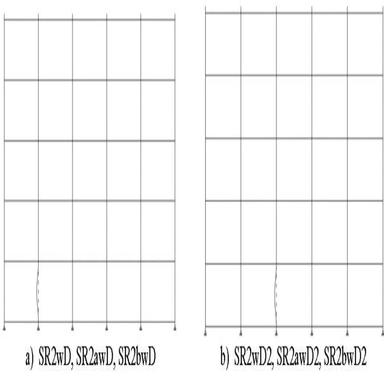
Damage scenarios: a) scenario 1 and b) scenario 2.